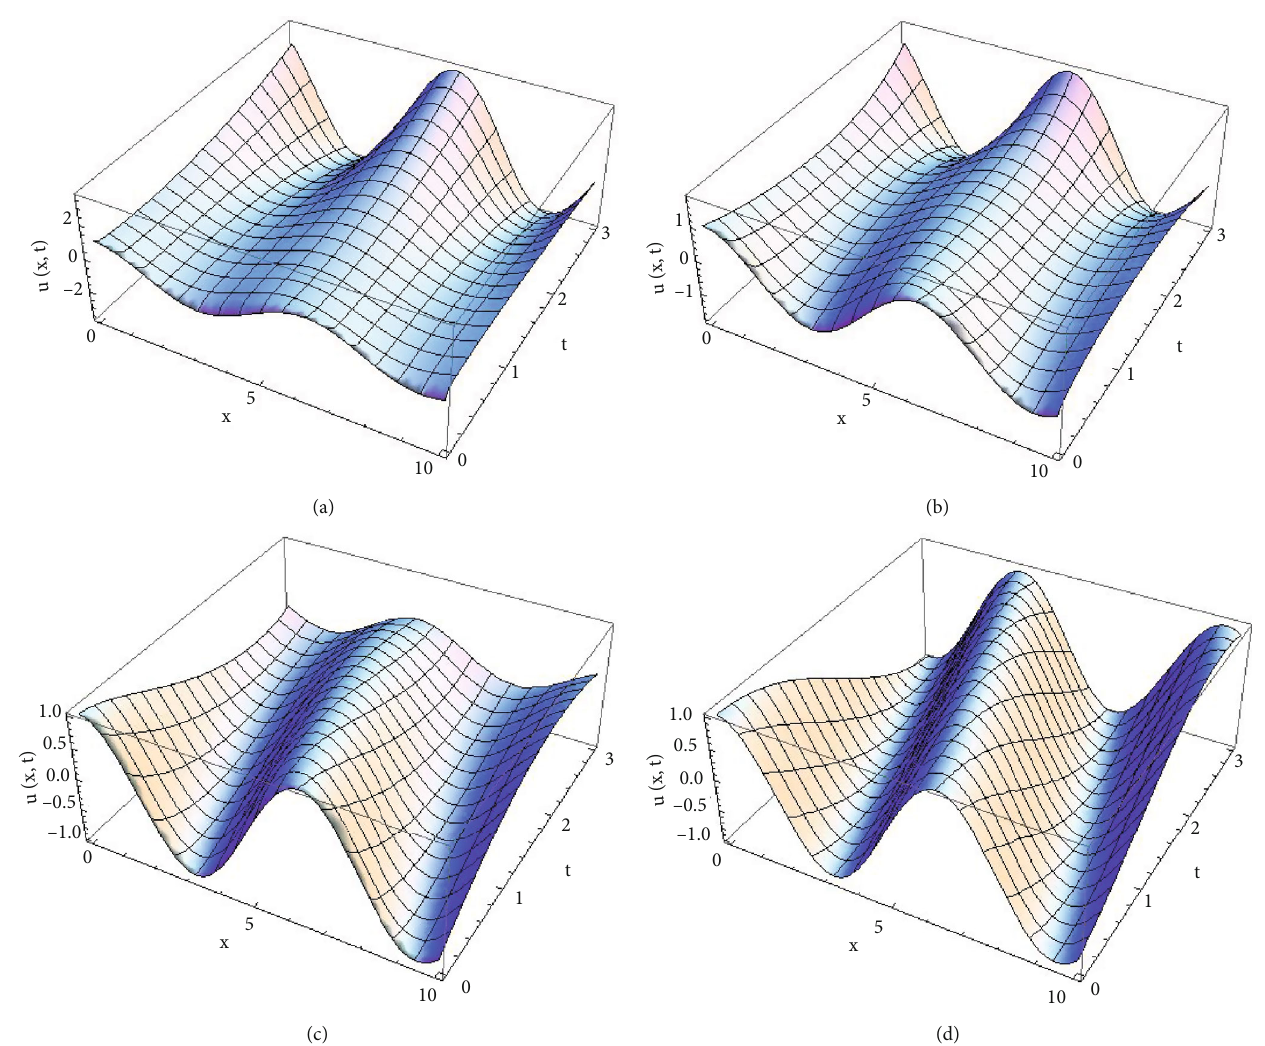
Figure 1: The physical behavior of FRDTM solution of Eq. (21) for (a) α = 0 : 25 , (b) α = 0 : 5 , (c) α = 0 : 75 , and (d) α = 1